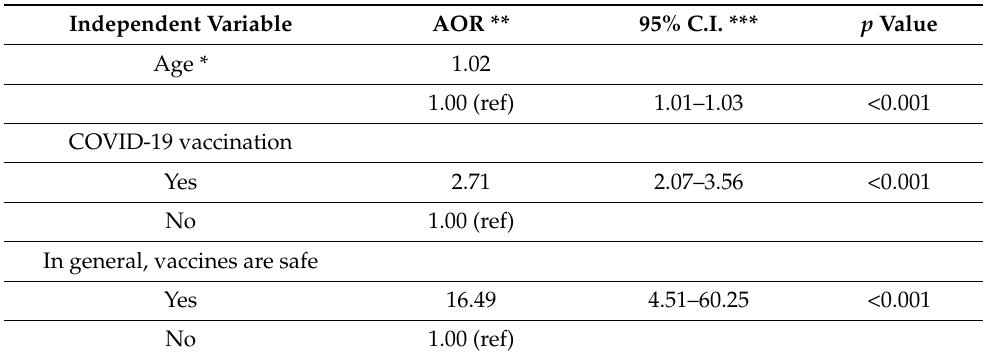
Table 2. Multivariable analysis of influenza vaccination coverage